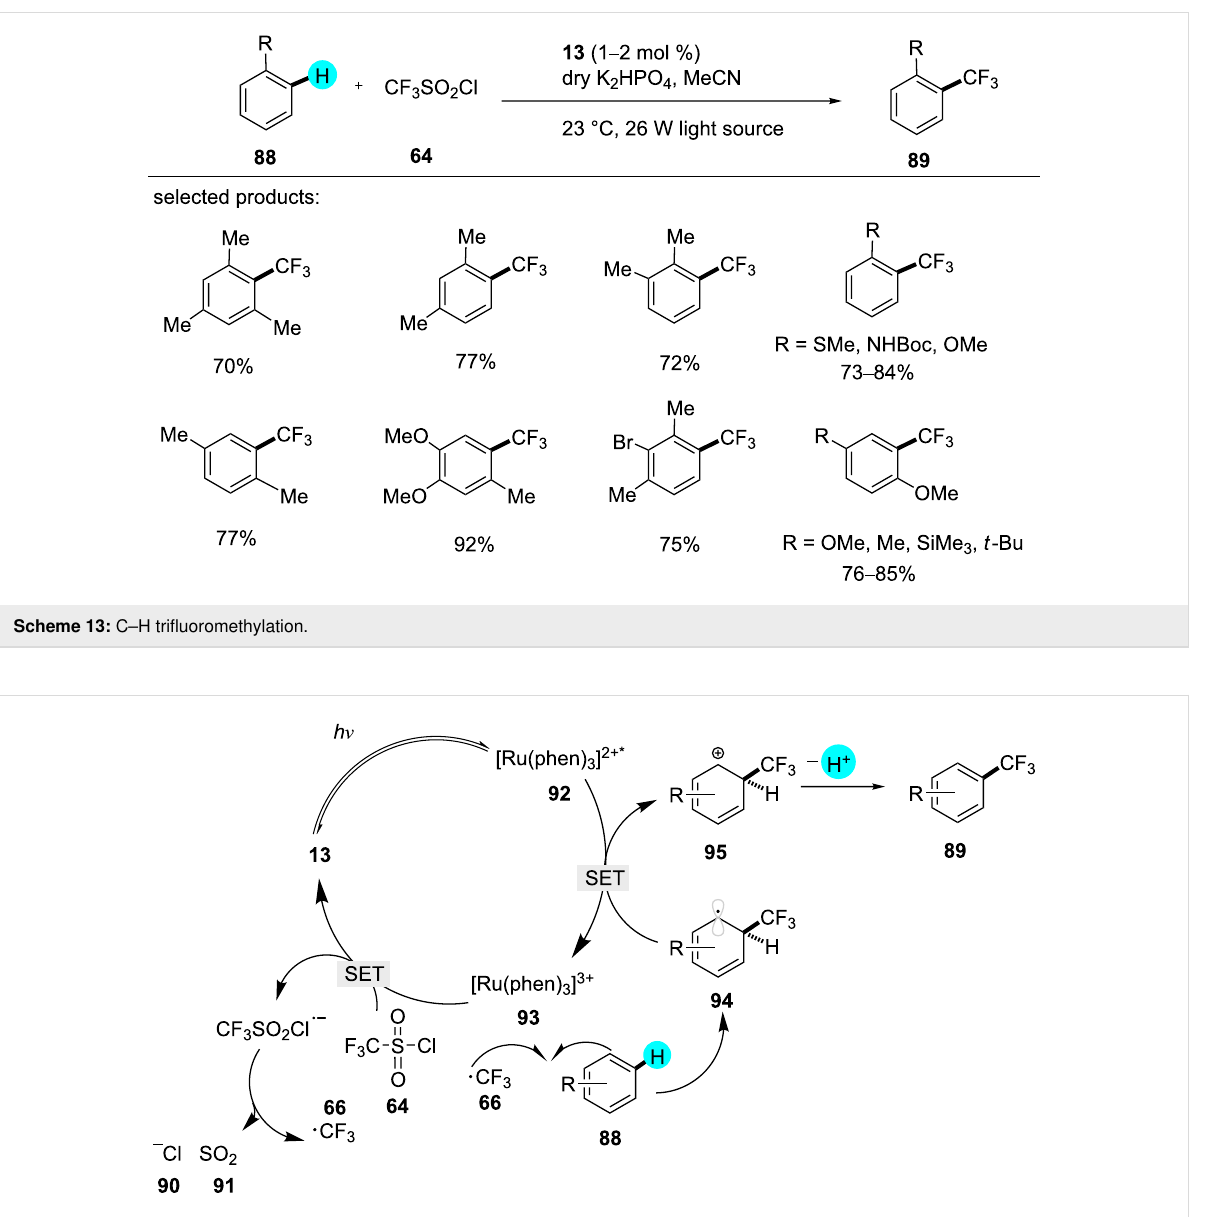
generated via SET, and after deprotonation of 104 , the phospho- nylated intermediate 105 is formed. The additive CH 3 COONH 4 causes nucleophile displacement, converting the arylphospho- nium salt into the phosphonylated product 101 . A range of products was assembled using this strategy, as displayed in Scheme 15, and a plausible mechanism for the reaction is shown in Figure